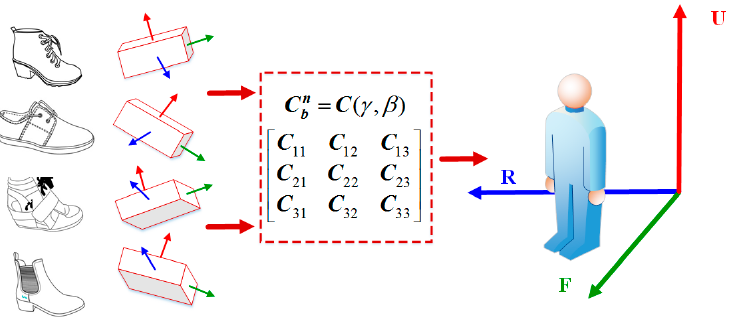
Figure 5. Inertial sensor measurement alignment.